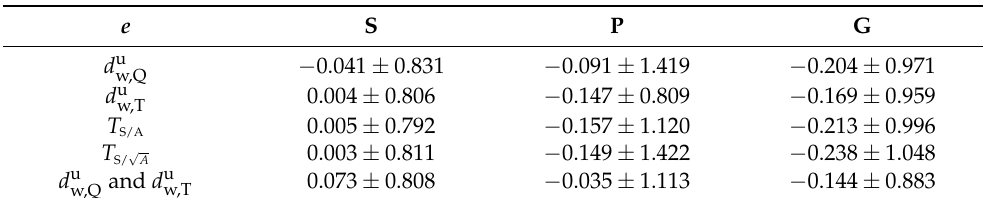
Table 6. Estimation errors ( e ) using stage-specific (S), patient-specific (P) and global (G) approach- based [ K + ] estimators, from all patients at all HD time points. Values are expressed as mean ± standard deviation and the units are